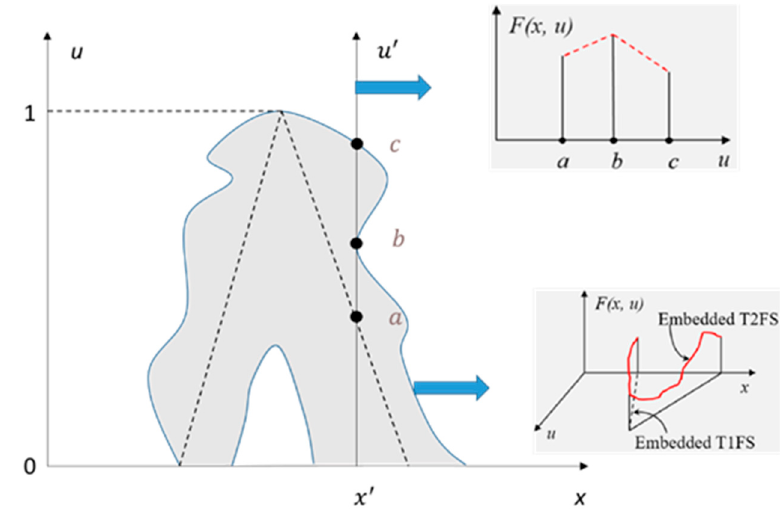
Figure 2. Membership function of type-2 fuzzy sets.